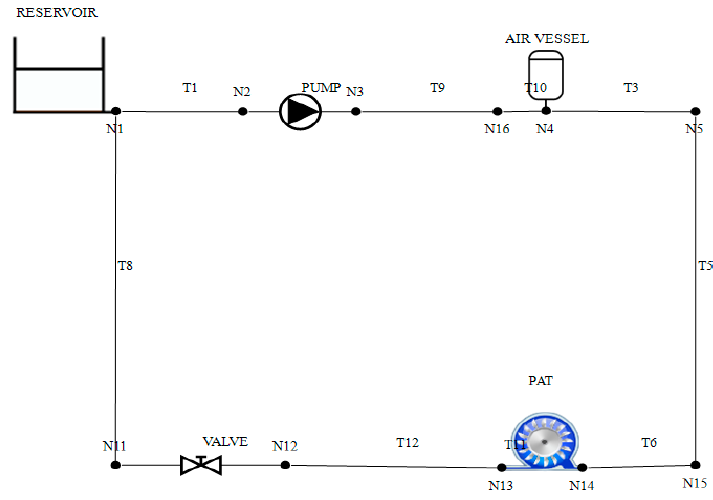
Figure 8. Simulation scheme used in Allievi model. Table 1. Basic parameters for the simulation.